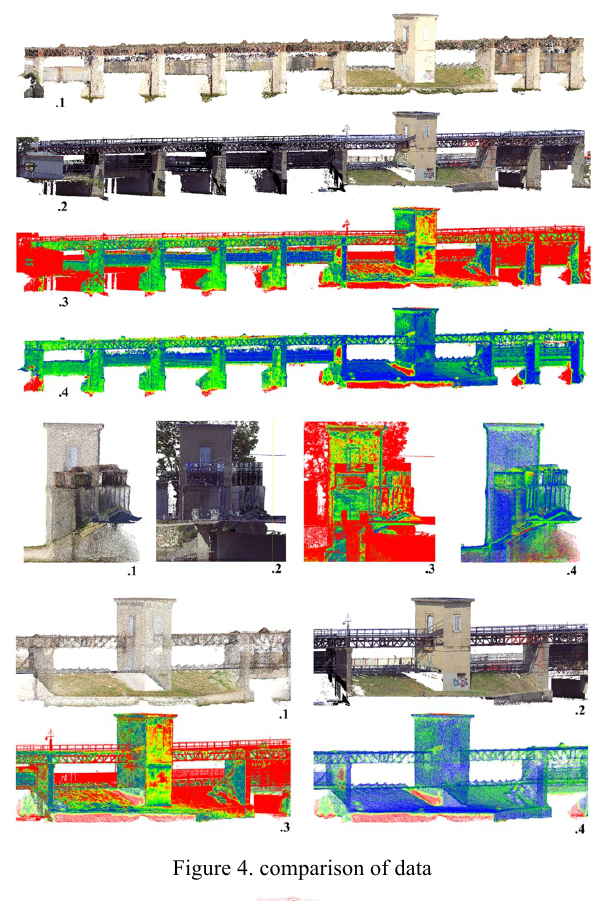
Figure 4. comparison of data